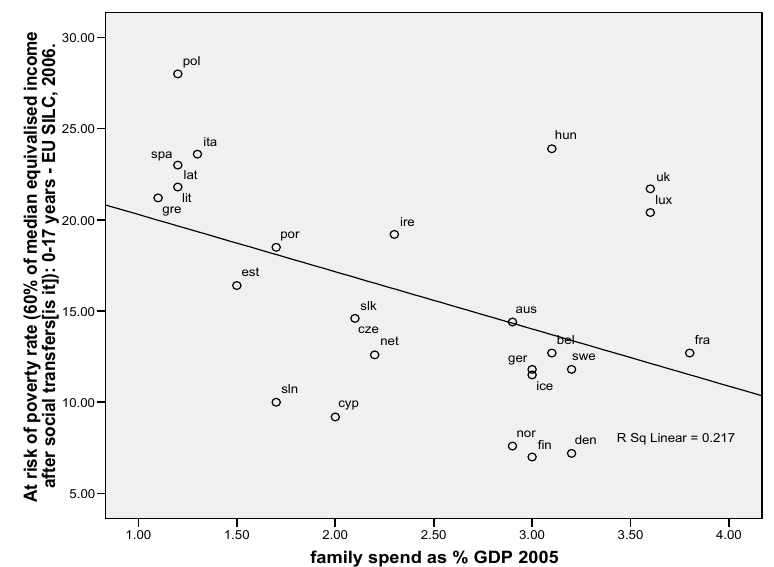
Figure 14 : Child income poverty rates 2006 by family spending as a proportion of GDP 2005